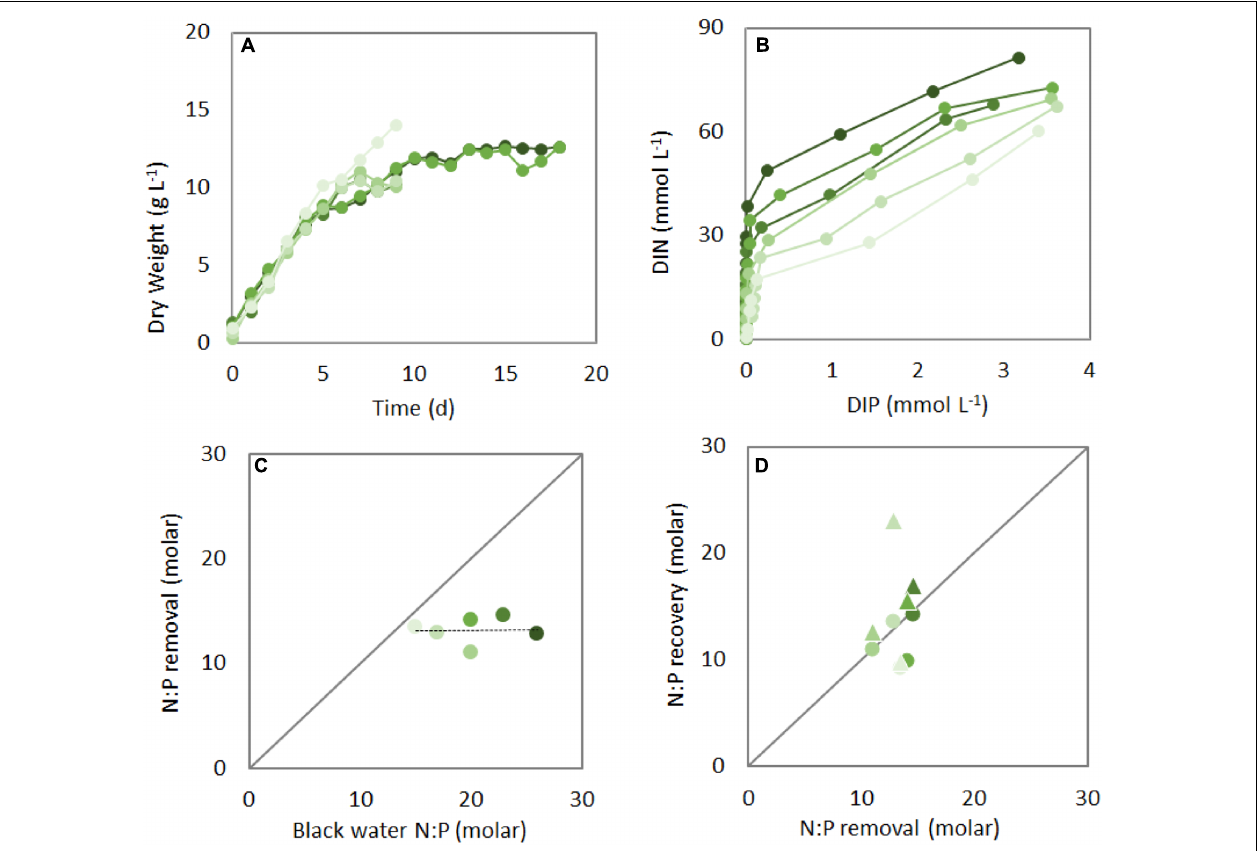
FIGURE 1 | Dynamics of biomass (A) , dissolved inorganic nitrogen (DIN) and phosphorus (DIP) (B) , N:P removal (C) , and N:P recovery (D) by Chlorella sorokiniana at different initial black water N:P ratios (green shades, darker colors represent higher N:P). Symbols in (A) and (B) indicate daily measurements. In (B) the highest N and P concentrations of the beginning of the experiment are at the top right corner. Symbols in (C) indicate the integrated N:P removal rates during the first 4 days of each experiment, and circles and triangles in (D) show the cellular N:P after the first 4 days and the end of the experiment,